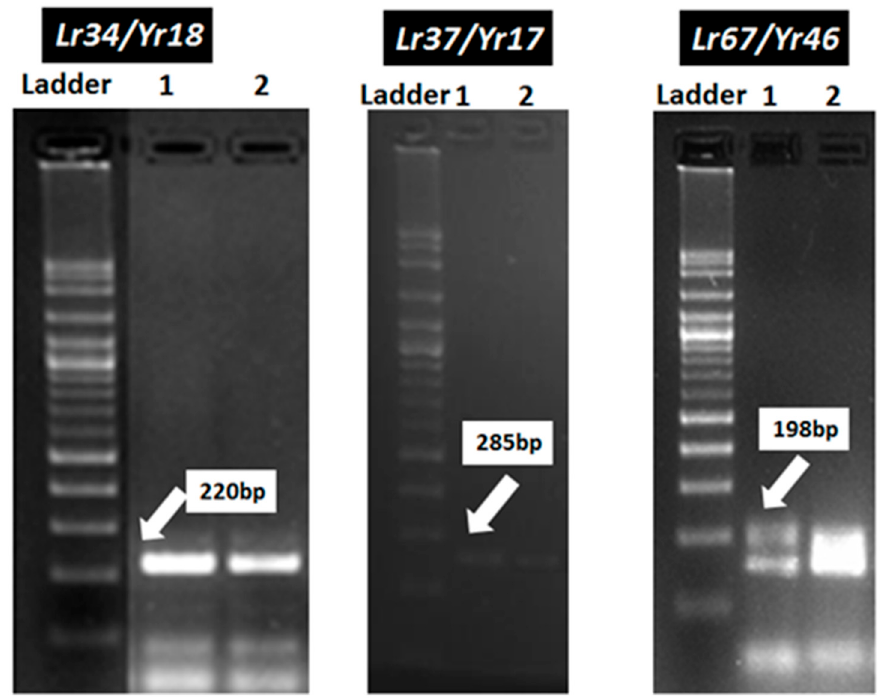
Figure 11. Electrophoretic amplified pattern of DNA extracted from six F 2 crosses using the specific primer of Lr34/Yr18 , Lr37/Yr17 and Lr67/Yr46 . Lane 1 = cross Sids-14, Lane 2 = cross Shandweel-1.